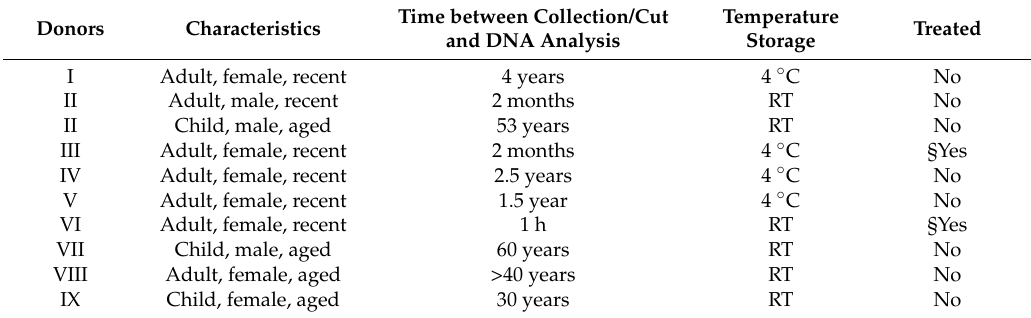
Table 1. Description of donors and hair samples used in this study. RT = Room Temperature (20–25 ◦ C). § Refers to permanent hair coloring.